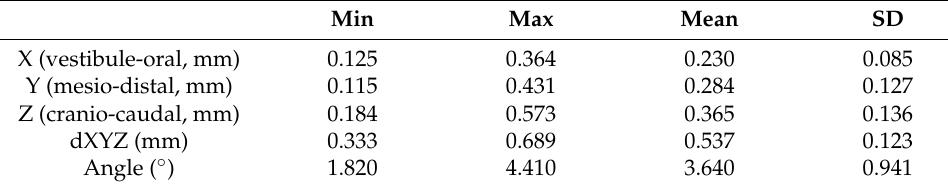
Table 3. Results of Mean, SD in all dimensions and angular data from 20 implants.